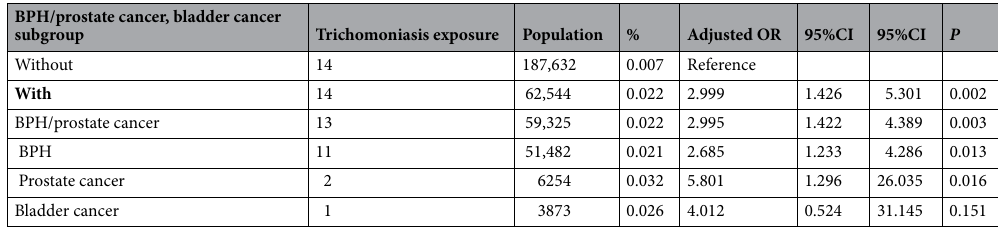
Table 4. BPH/prostate cancer and bladder cancer subgroups analyzed using multivariable logistic regression. Adjusted OR adjusted odds ratio (adjusted for the variables listed in Table 2), CI confidence